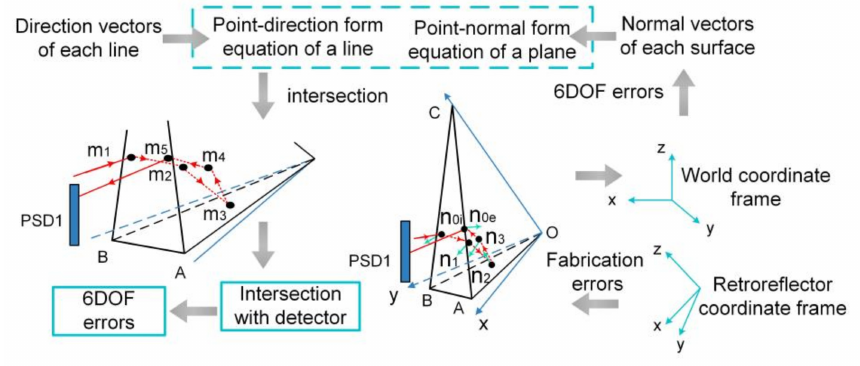
Figure 11. Basic idea of establishing the error compensation model using